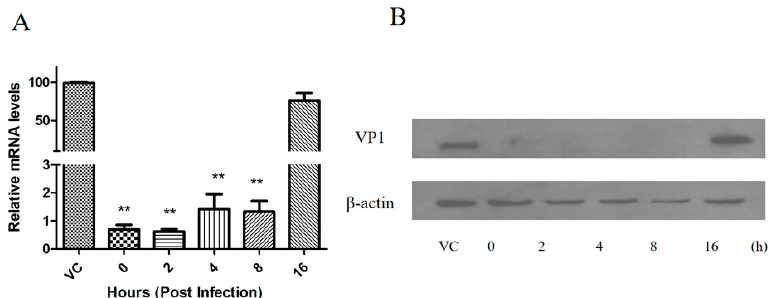
Figure 4. Time points of drug-addition study in FMDV replication. IBRS-2 cells were infected with 100 TCID 50 O/MY98/BY/2010 followed by treatment of 75 μ M mizoribine at indicated time (hours post-infection (hpi)). Virus levels were determined at 48 hpi by ( A ) Q-PCR and ( B ) Western blot. “VC” represents those cells treated with 1% DMSO without mizoribine. Values represent the mean ± standard deviation for three independent experiments. The asterisks indicate significant di ff erences between mock-treated and drug-treated cells (** p < 0.01).